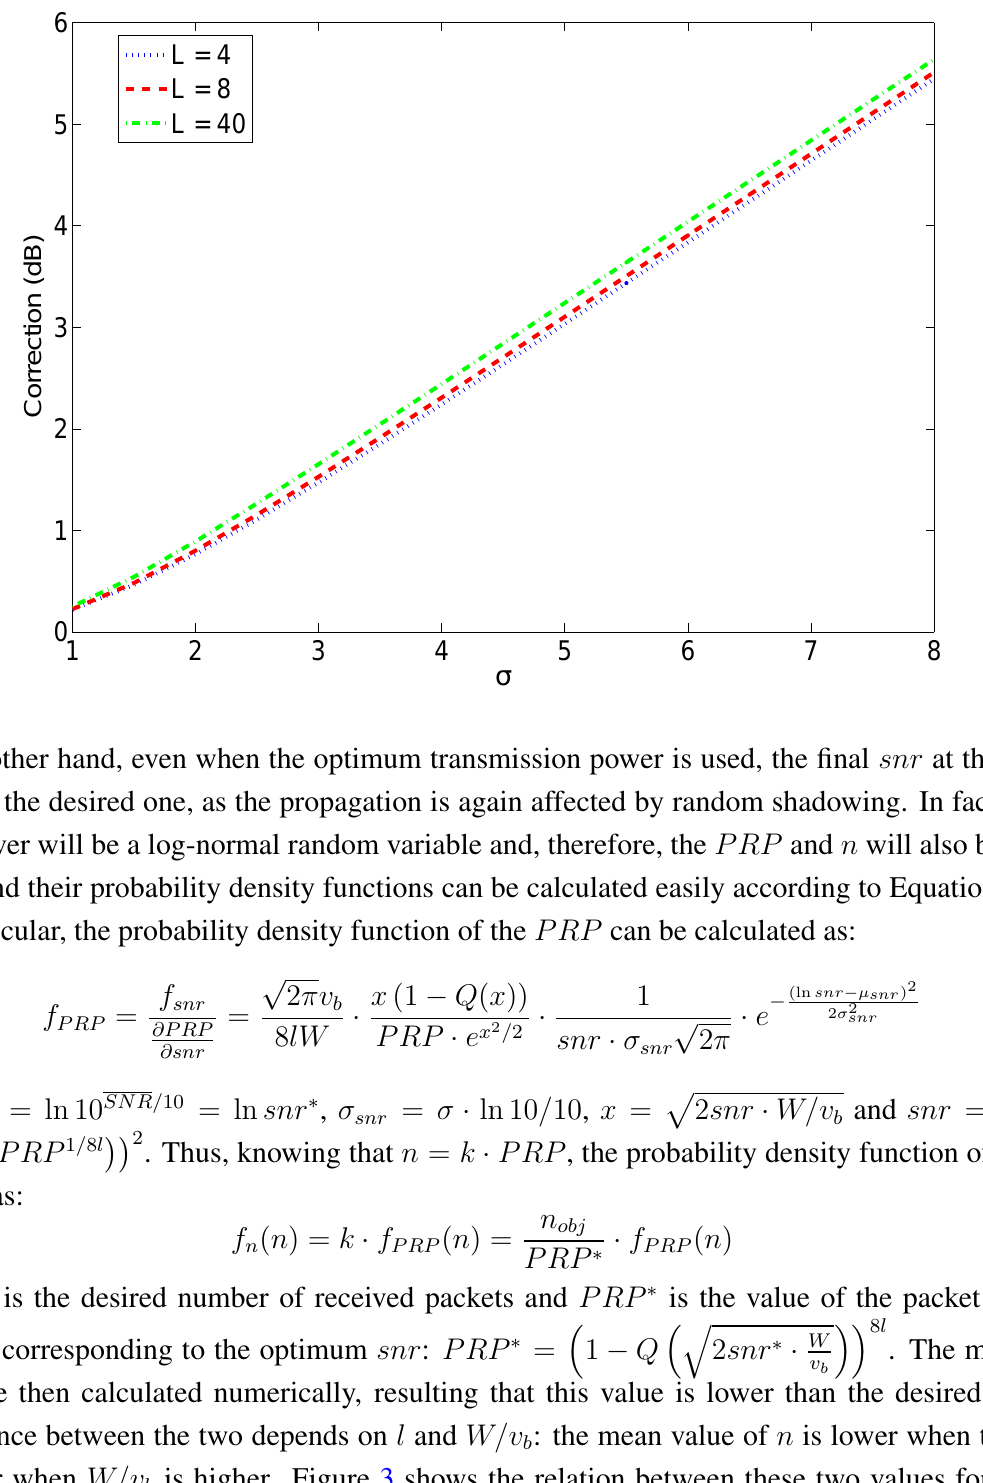
Figure 2. Correction margin for the transmission power calculated from estimated distances in RSS-based